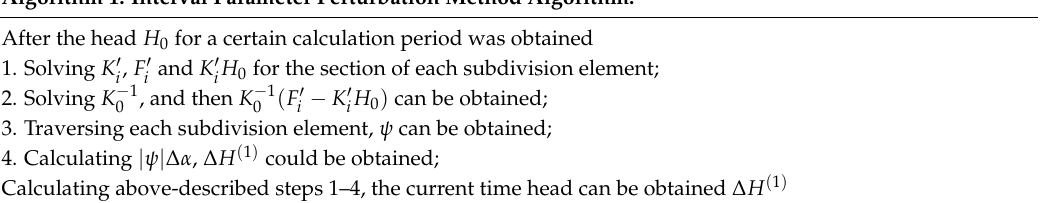
Algorithm 1. Interval Parameter Perturbation Method